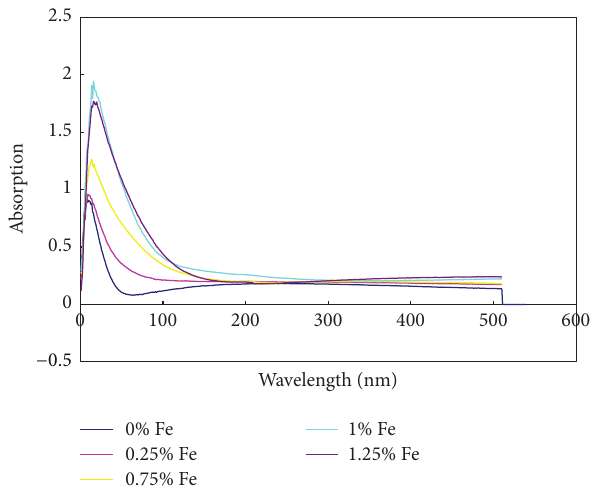
Figure 3: UV-Vis absorption spectra.